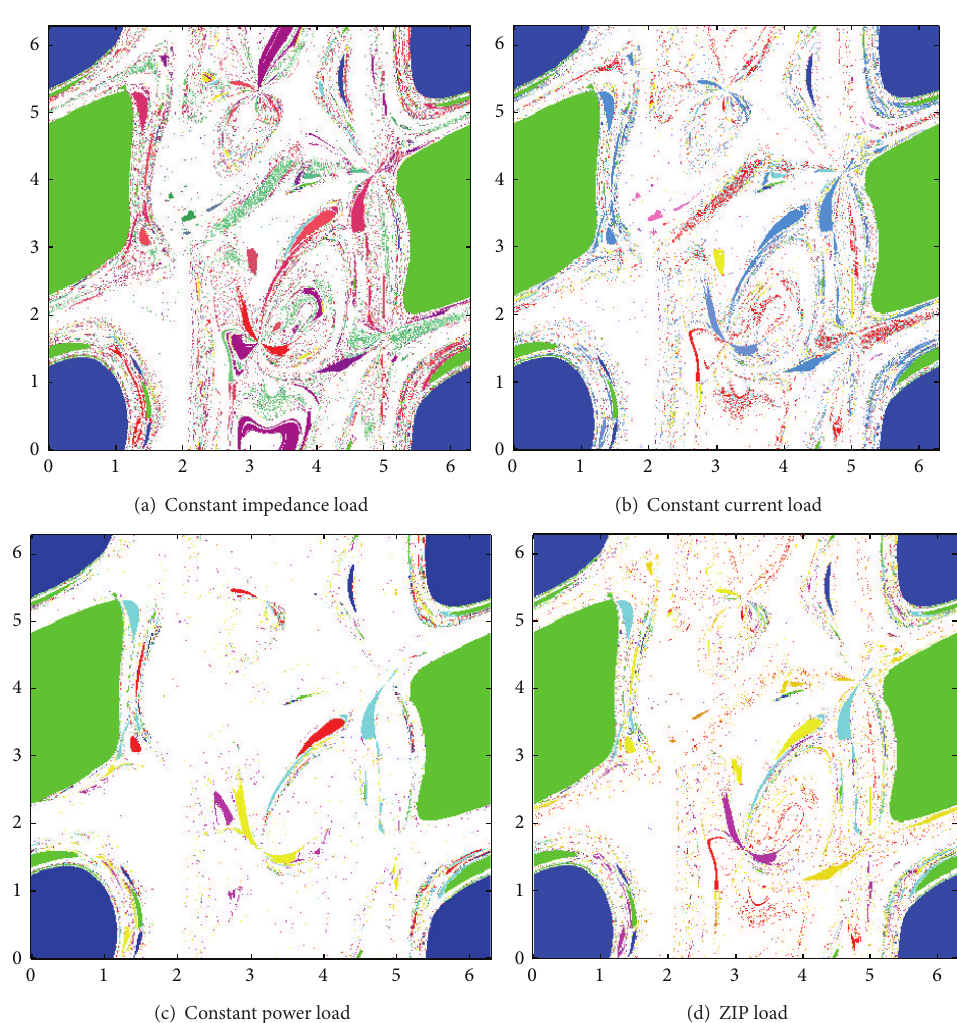
Figure 7: Convergence region of IEEE 14-bus system with different load models on ( 𝜃 2 ,𝜃 3 ) plane: (a) constant impedance load; (b) constant current load; (c) constant power load; (d) ZIP load.